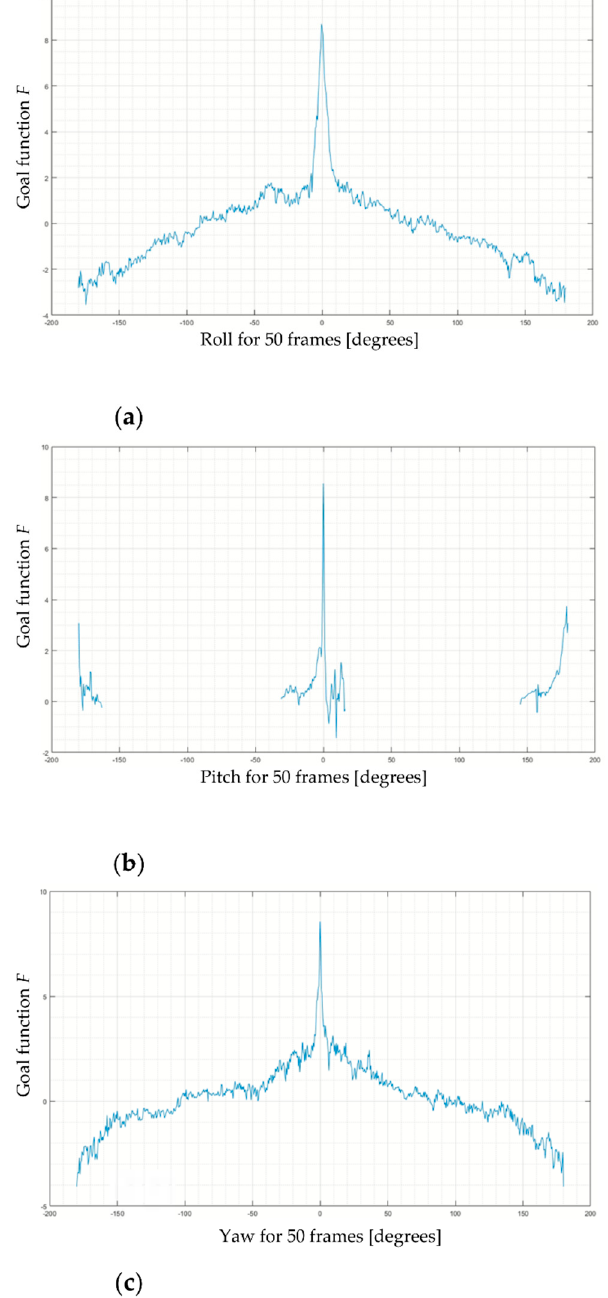
Figure 6. The intersection of goal function F in the whole range of angles of roll, pitch, and yaw, from − 180° to 180°. For each chart, one angle is presented on the axis X and other two angles are set to 0. ( a ) Roll for 50 frames, ( b ) Pitch for 50 frames ( c ) Yaw for 50 frames.